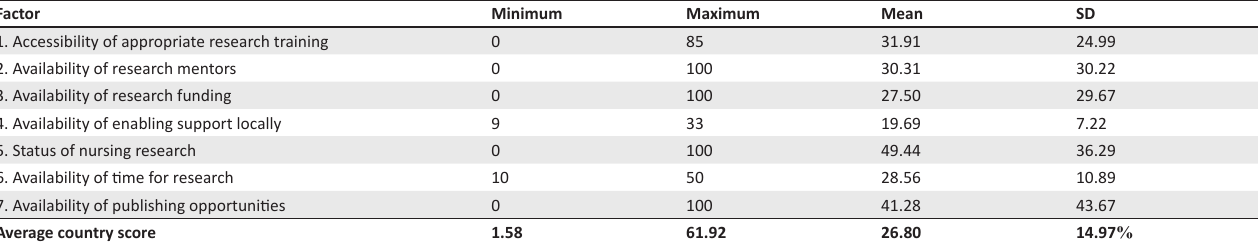
TABLE 2: Total level of support in 15 countries across seven factors (in % ). Factor